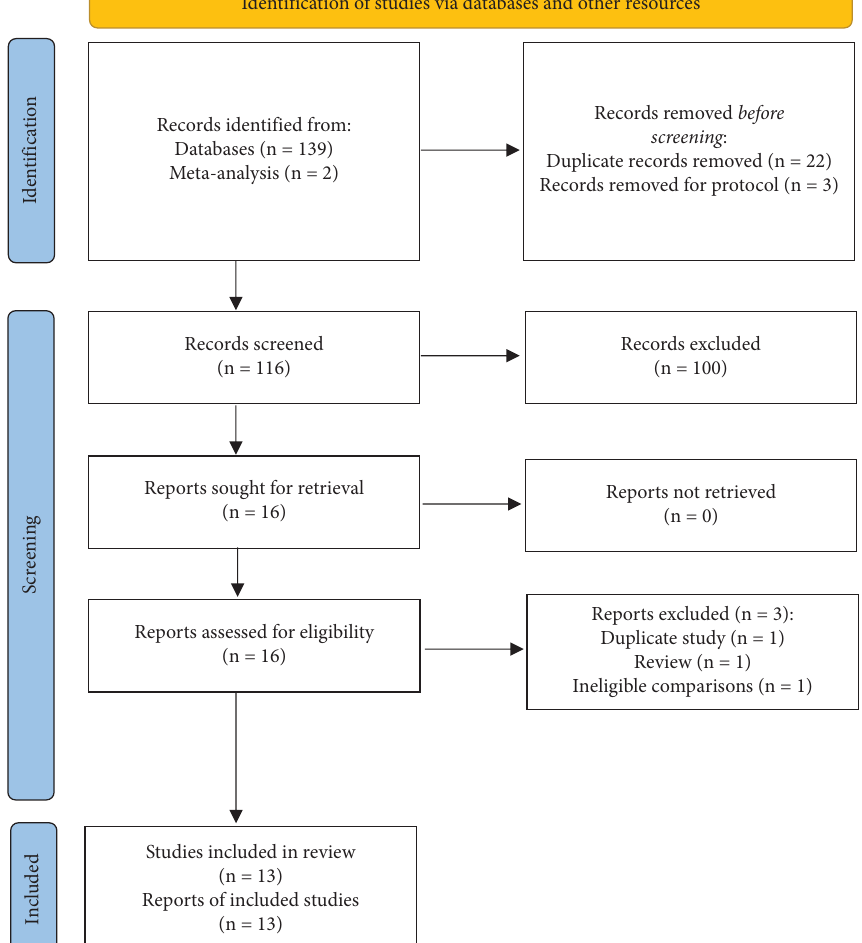
Figure 1: PRISMA fow diagram of study